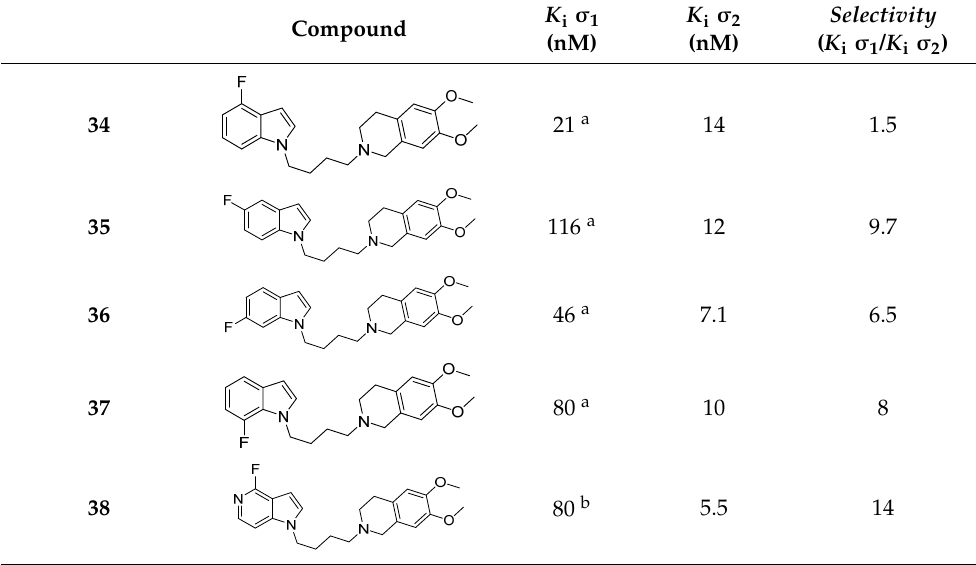
Table 1. In vitro binding affinities of compounds 34 – 42 towards the σ 1 receptor and the σ 2 receptor.